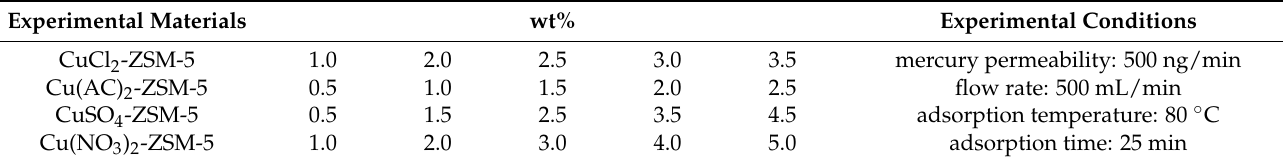
Table 1. Experimental design of the modified ZSM-5 molecular